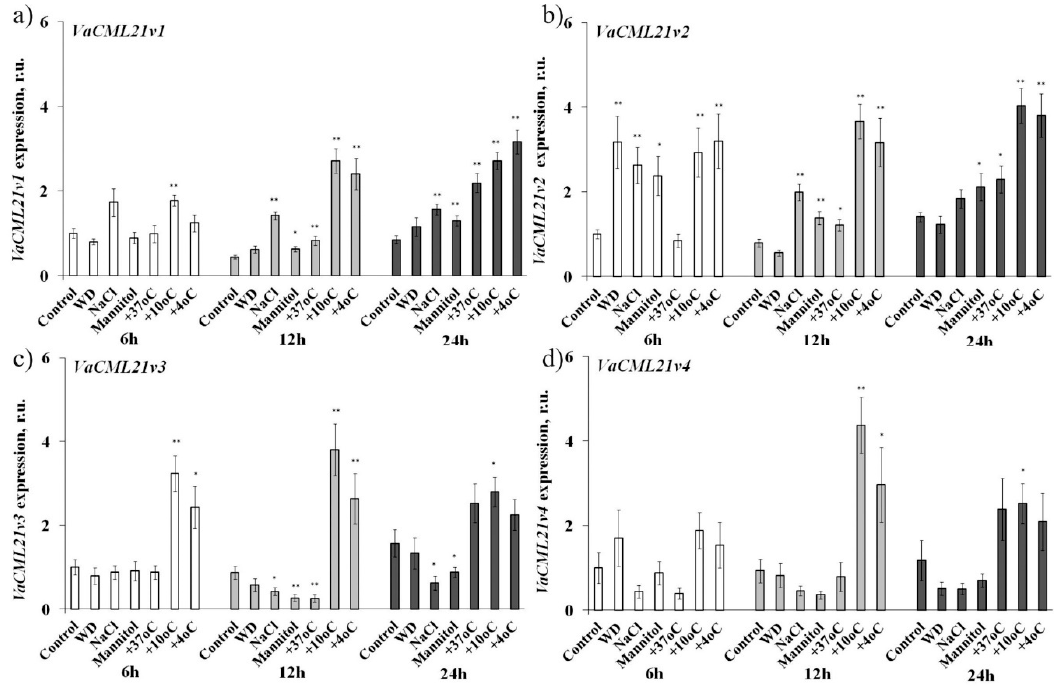
Figure 2. Expression analysis of VaCML21v1 ( a ), VaCML21v2 ( b ), VaCML21v3 ( c ), and VaCML21v4 ( d ) splice variants 6 h, 12 h, and 24 h post-treatment in the leaves of V. amurensis exposed to control (Control, filtered water, +25 °C), water-deficit (WD, cuttings laid on a paper towel, +25 °C), high salt (0.4 M NaCl, +25 °C), osmoticum (0.4 M mannitol, +25 °C), low temperature (+10 °C and +4 °C), and high temperature (+37 °C) abiotic stress conditions. The expression of the CMLs was profiled by quantitative real-time RT-PCR. The data are presented as the mean ± SE (three independent experiments). *, **—significantly different from the Control for each time point at p ≤ 0.05 and 0.01 according to Student’s t-test.